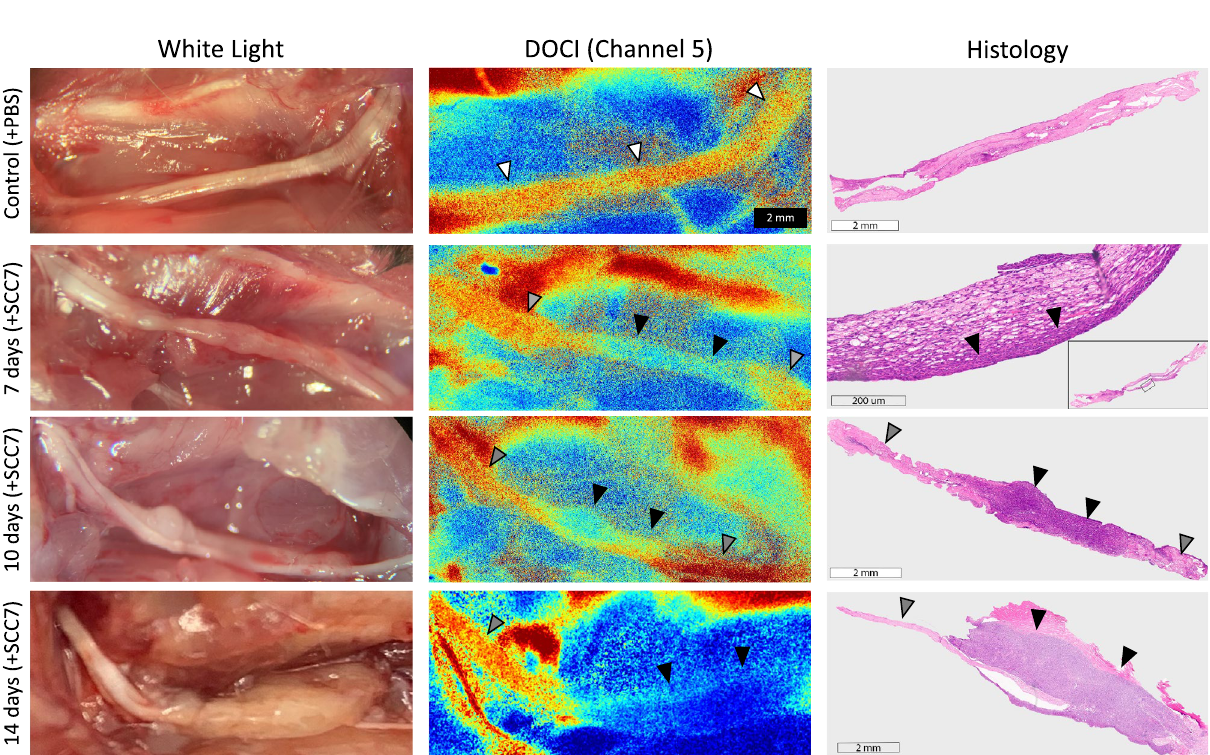
Figure 3. DOCI accurately identifies perineural invasion. The left sciatic nerves were injected with PBS while the right sciatic nerves were injected with SCC7. Sciatic nerves were harvested at 7, 10, and 14 days. All nerves underwent white light imaging, DOCI imaging, and permanent histologic sectioning. White arrowheads denote the control nerve, black arrowheads PNI, and grey arrowheads the normal nerve adjacent to the